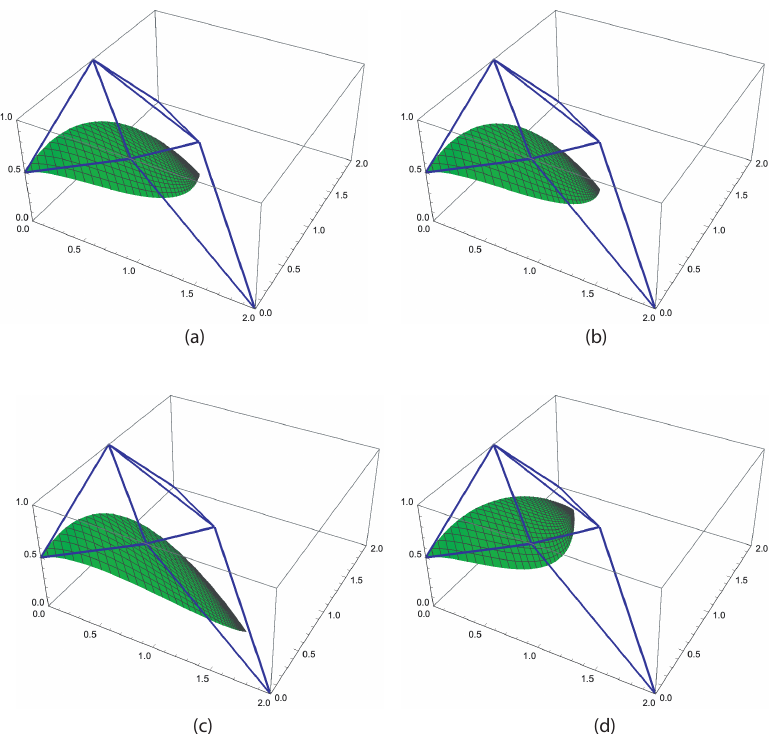
Figure 8: The graphs of redistributed triangular Meyer-König-Zeller surfaces with m = 2, n = 3 and different { ω 2, l } .